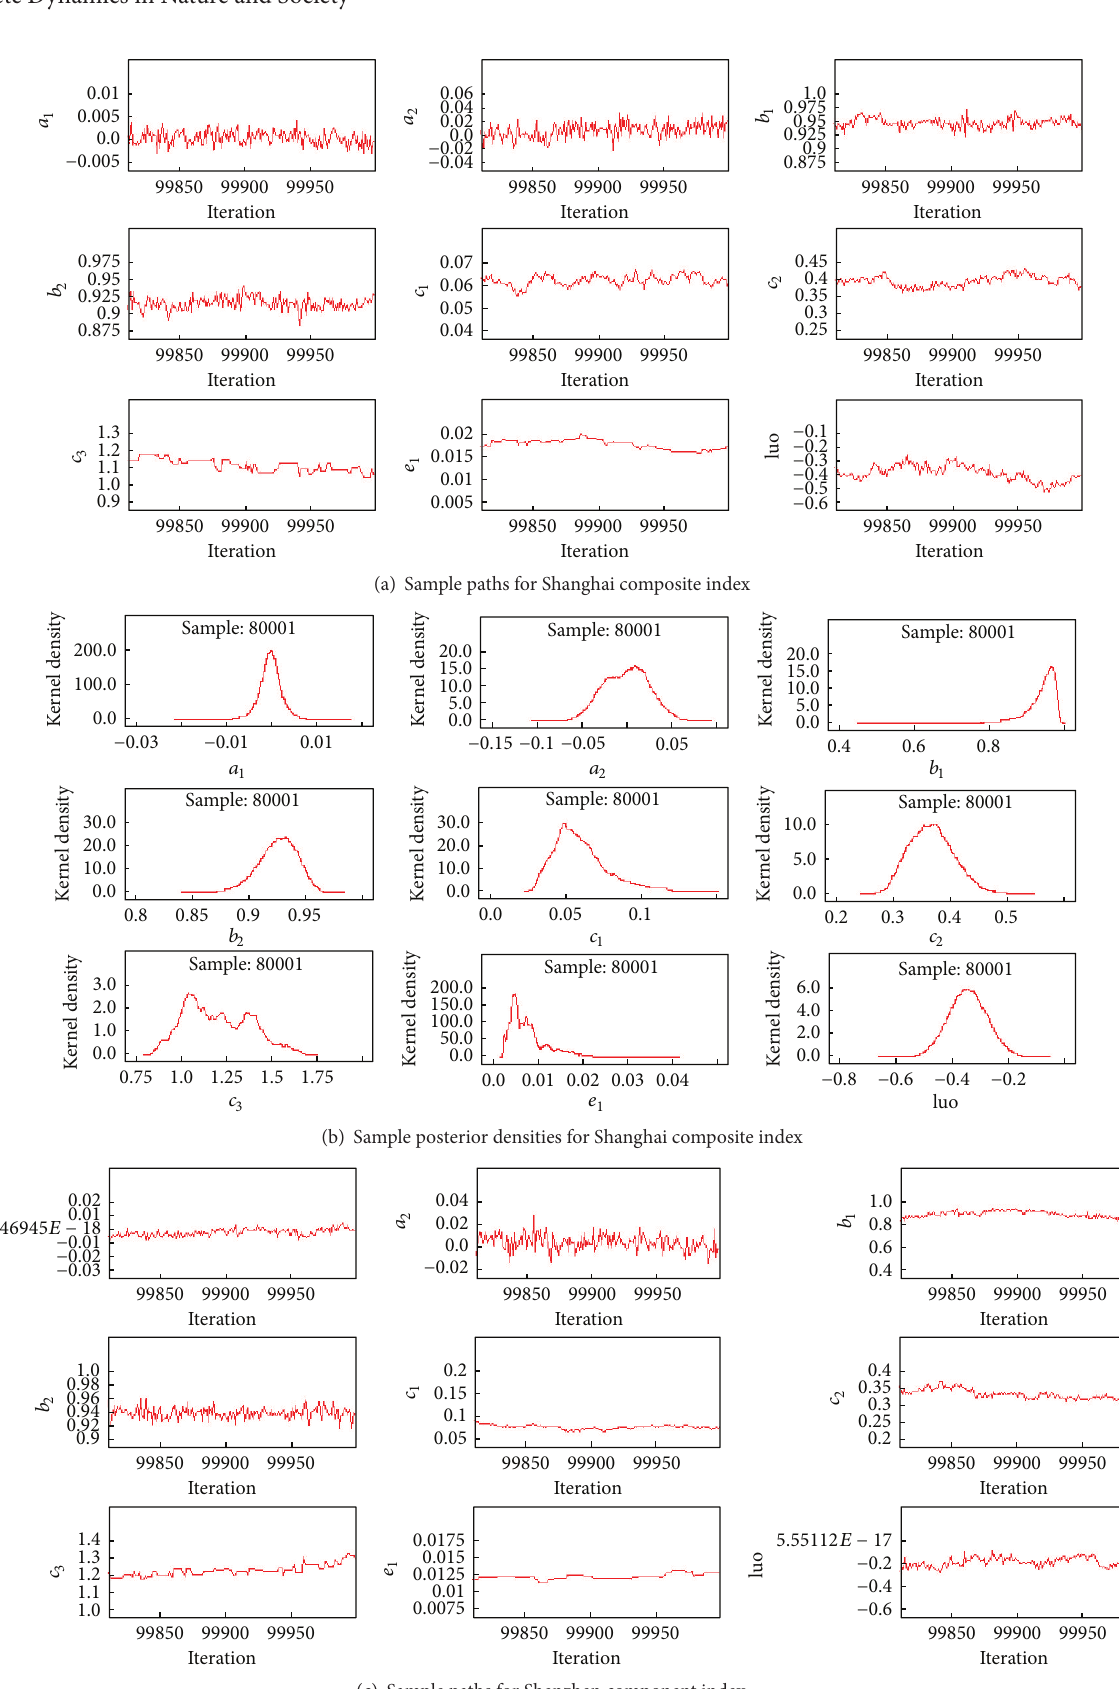
(c) Sample paths for Shenzhen component index Figure 5: